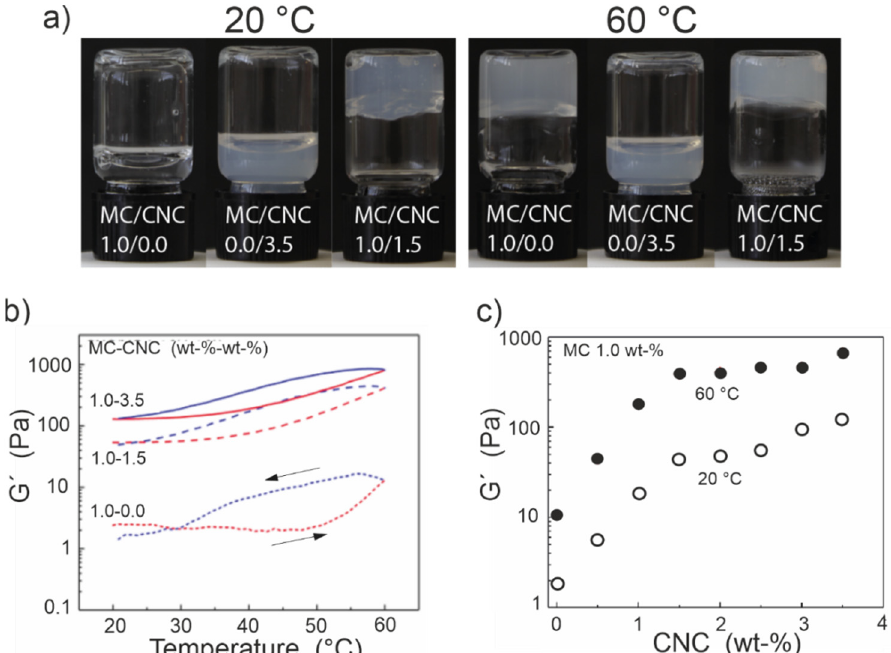
Figure 4. Mechanical properties of MC-CNC nanocomposite gels. ( a ) General appearance of pure MC, pure CNC, and a MC-CNC mixture compared at 20 ◦ C and 60 ◦ C. ( b ) Changes of storage moduli (G (cid:48) ) for three different MC-CNC nanocomposite hydrogels with heating and cooling cycle. The CNC content tunes the baseline stiffness when MC is kept constant, but all gels show fully reversible and thermally induced stiffening. ( c ) Storage modulus (G (cid:48) ) of MC-CNC hydrogels as a function of the CNC loading, when MC content is fixed, at 1% at 20 ◦ C and 60 ◦ C. Heating allows further reversible stiffening of ca. one order of magnitude. Note the logarithmic Y-axis scale. Adapted with permission from [31] (https://pubs.acs.org/doi/full/10.1021/acs.biomac.8b00392, date accessed on 3 September 2021). Copyright 2018 American Chemical